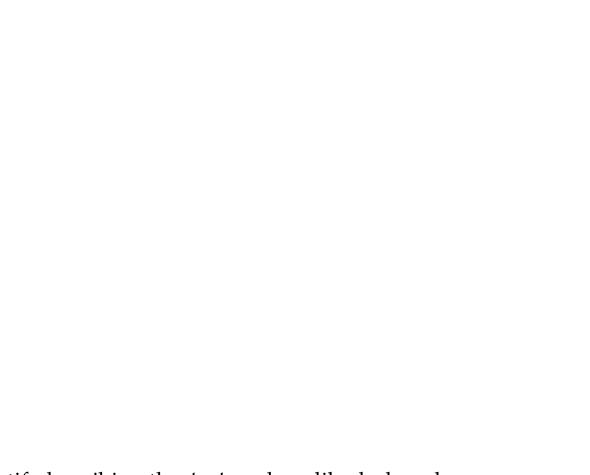
Figure 8. Prototypical C-X 1 -X 2 -H-X 3 motif, describing the ϕ , ψ and χ 1 dihedral angles. Table 4. Average dihedral angles of clusters expressed in degrees. The number of structures per cluster is shown in the brackets of the first column. Standard deviations are reported in parentheses. Cluster φ i+1 ψ